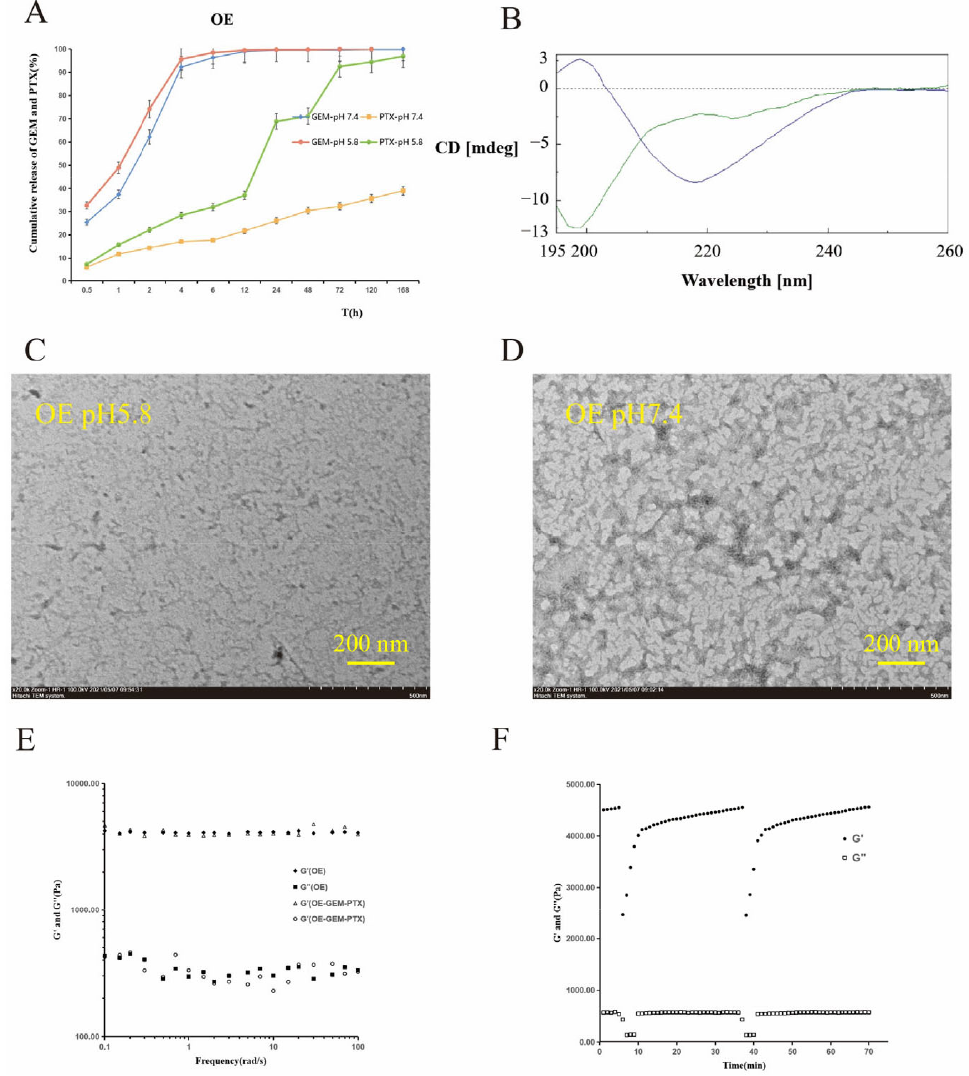
Figure 1. Cumulative release of GEM and PTX from OE hydrogel in different buffer solutions with pH 5.8 and pH 7.4 ( A ). Circular dichroism chromatograms of blank OE peptide in pH 5.8 and pH 7.4 buffers ( B ). Transmission electron microscopy of blank OE peptide at pH 5.8 ( C ) and pH 7.4 ( D ). Dynamic frequency scanning of blank OE hydrogels and GEM+PTX-loaded hydrogels ( E ). Dynamic time scanning of OE peptide hydrogels ( F ).